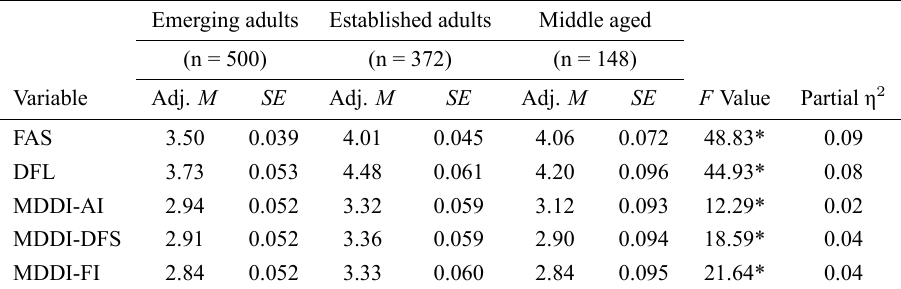
Table 2. Adjusted means and standard error for body image by gender. Emerging adults Established